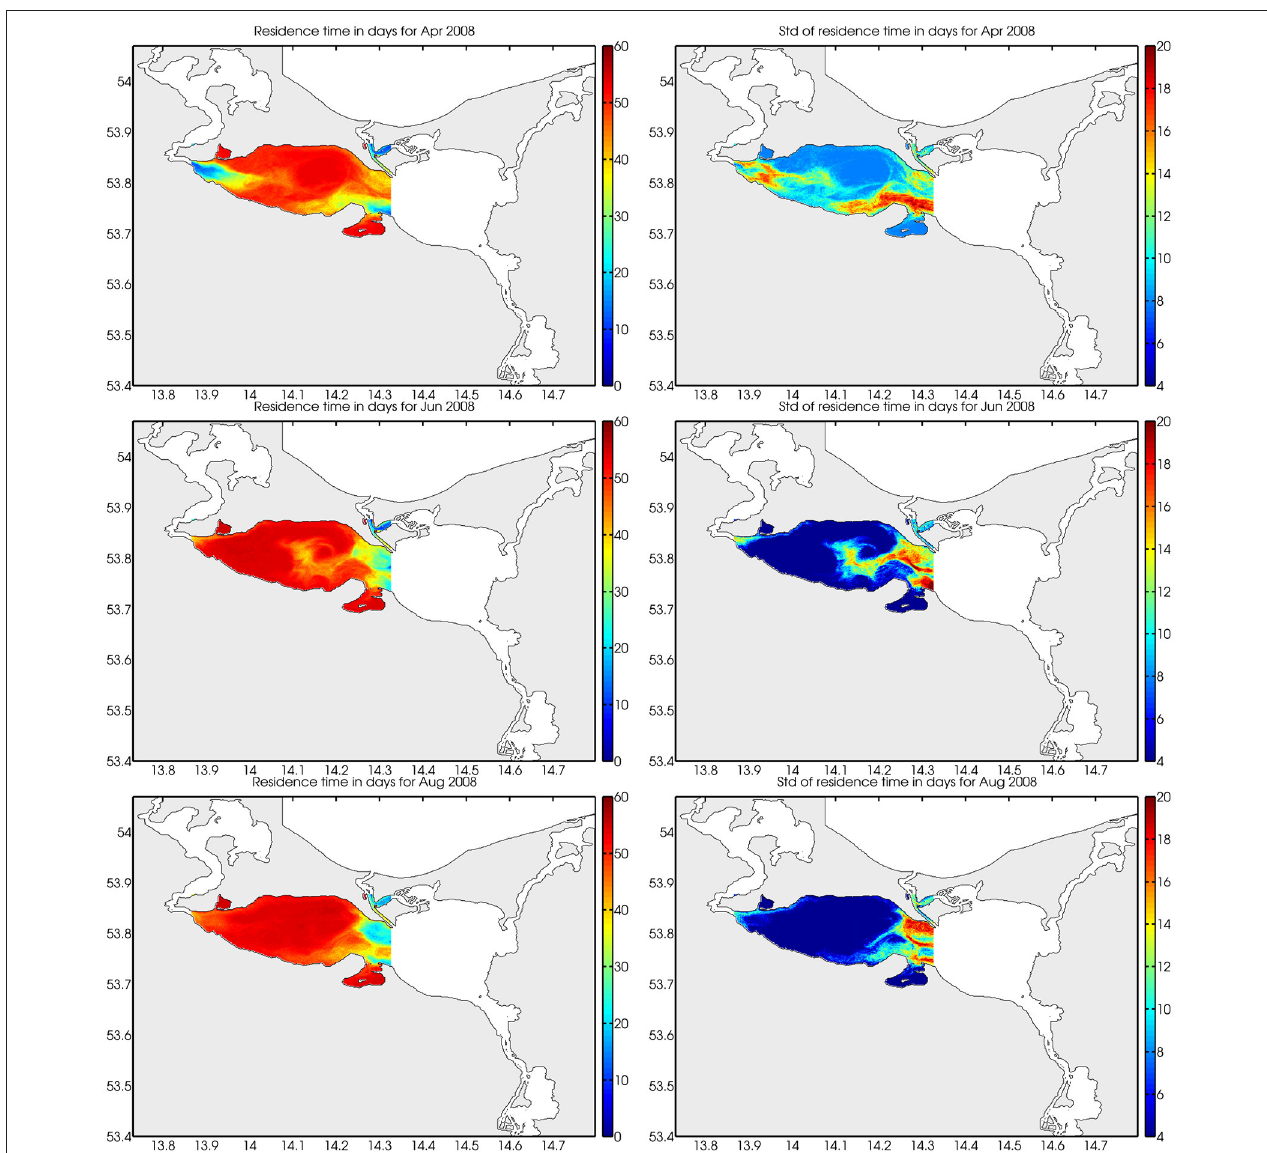
FIGURE 9 | Water residence times in Small Lagoon in April, June and August 2008 (Left) and their standard deviations (Right) calculated using ERGOM-GETM. Small Lagoon is always characterized by residence times near to the maximal value (the particle were only followed for 60